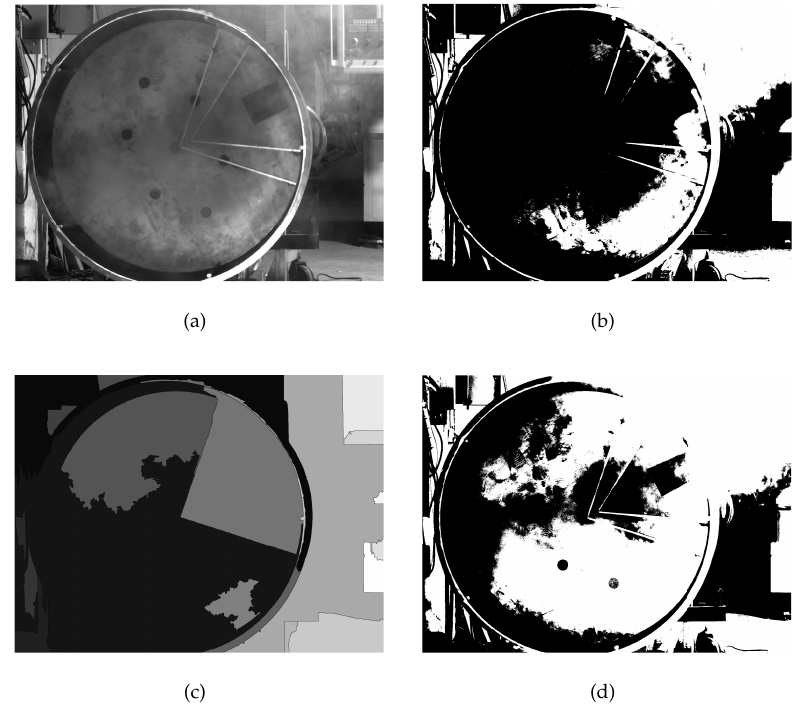
Figure 4. The results of classical image segmentation. ( a ) raw image; ( b ) Otus; ( c ) watershed algorithm; ( d ) histogram